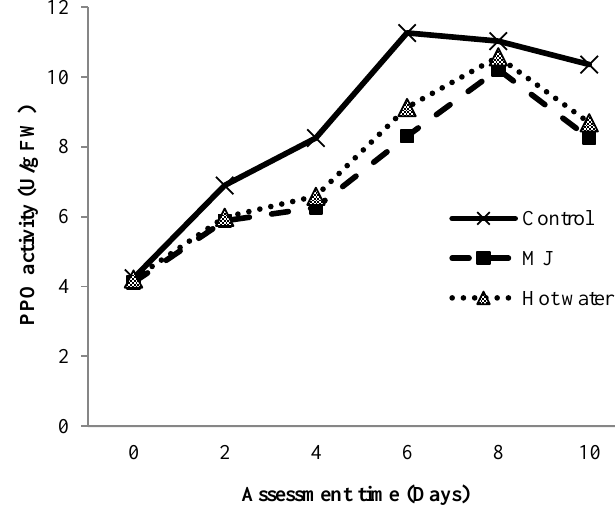
Figure 3. Effects of different postharvest treatments on weight loss of apricot fruits during storage at room temperature (MJ: methyl jasmonic acid).